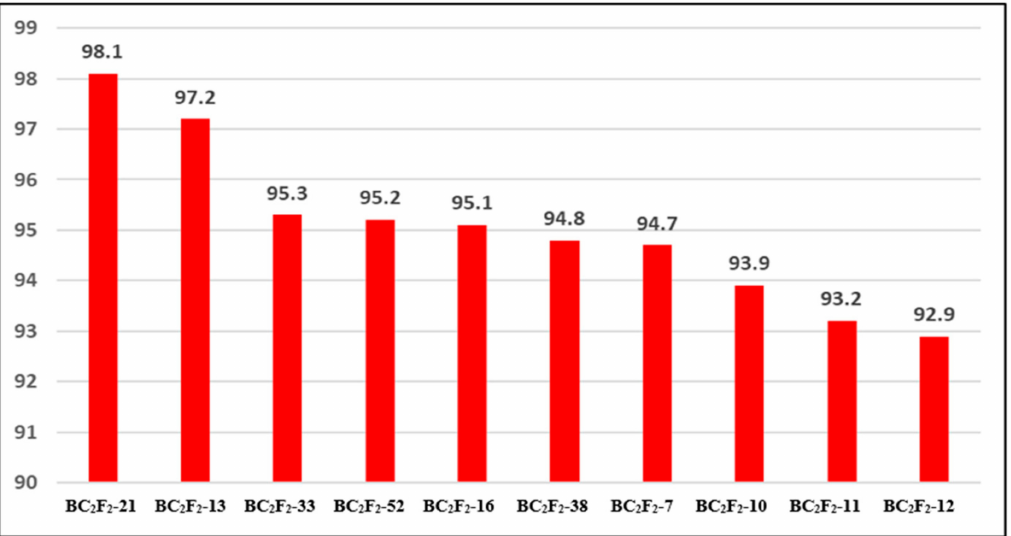
Figure 6. The 10 selected BC 2 F 2 progenies of recurrent parent genome recovery